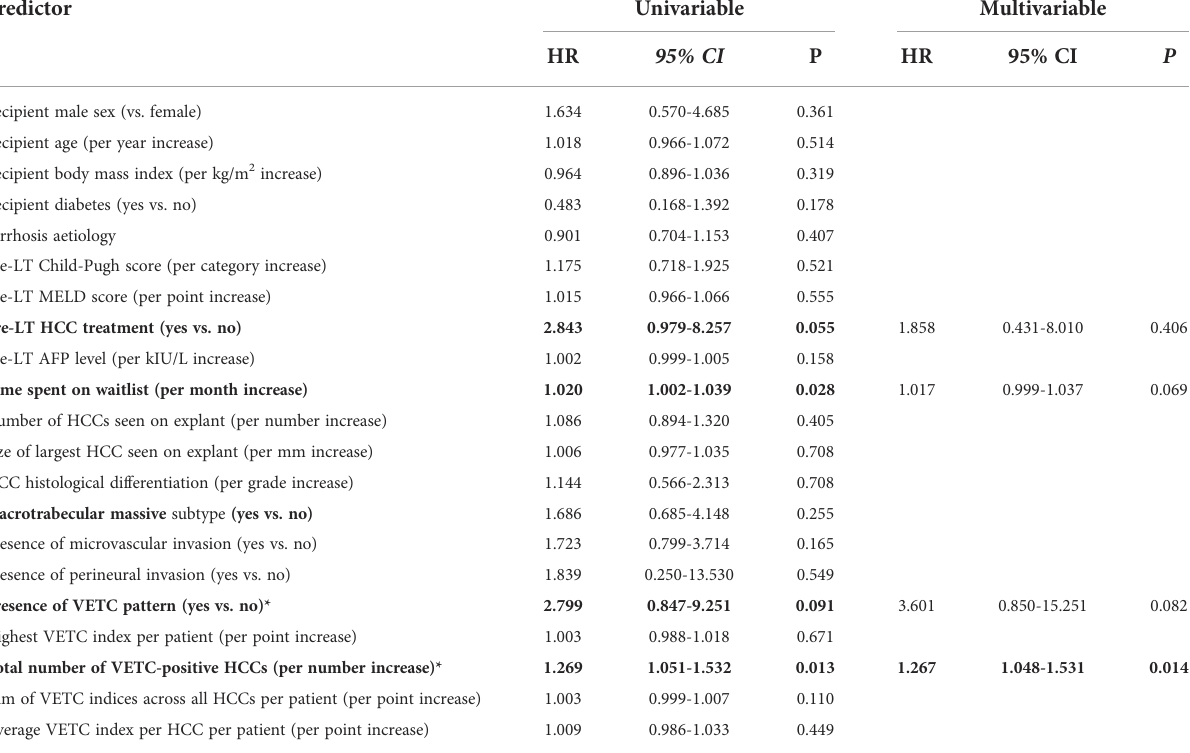
TABLE 4 Univariable and multivariable predictors of HCC recurrence or mortality (Recurrence-free survival).